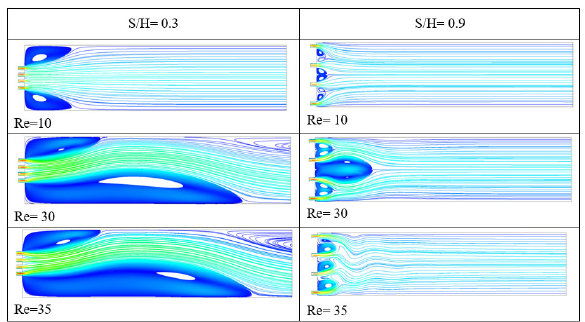
Figure 7: Streamlines of characteristic flows for S/H = 0.3, 0.9 in four